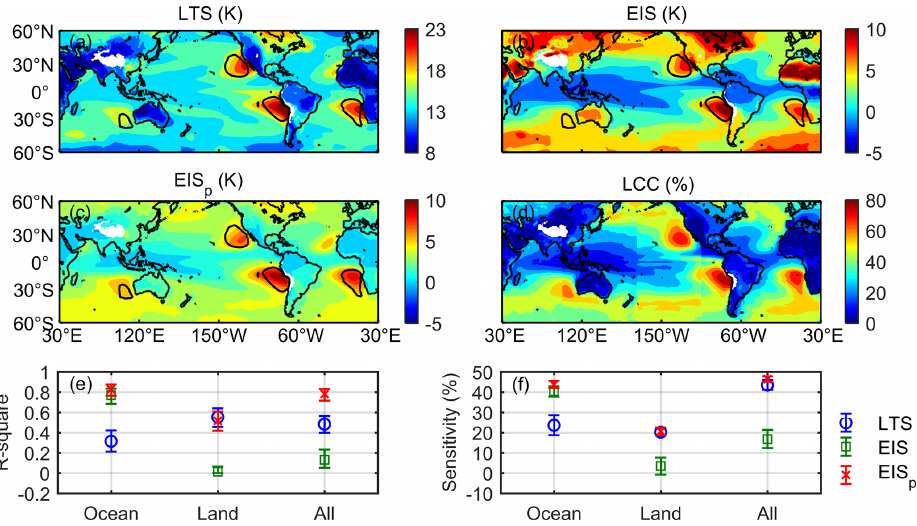
Figure 8. Spatial distribution of the ERA5 reanalysis-based LTS (a) , EIS (b) , EIS p (c) and the GEO-MODIS LCC (d) between 60 ◦ S and 60 ◦ N. The black contours enclose regions with LCC larger than 60%. The specific R square and LCC sensitivity to the LTS (blue cycle), EIS (green square) and EIS p (red cross) over the ocean, land and all is shown in (e) and (f) , respectively. The error bars show the 95% confidence interval of the mean based on the t test.